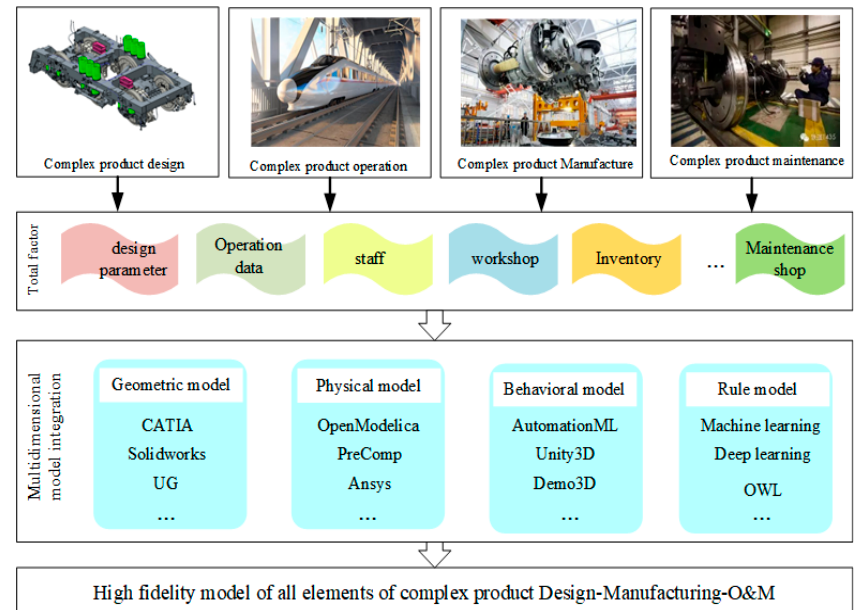
Figure 5. High ‐ fidelity modeling of complex products. Figure 5. High-fidelity modeling of complex